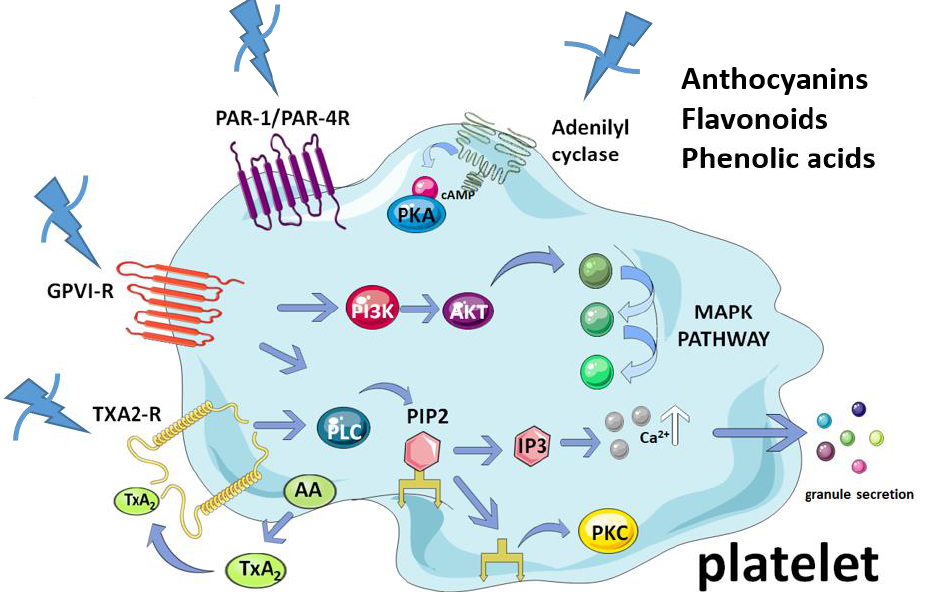
Figure 5. Antiplatelet mechanistic proposal for Maqui. AC, adenylate cyclase; AKT, protein kinase B; cAMP, cyclic adenosine monophosphate; DAG, diacylglycerol; PI 3 , phosphoinositol 3 kinase; PIP2, phosphatidylinositol bisphosphate; GP, glycoprotein; MAP, mitogen-activated protein kinase; P2Y12/P2P1, ADP receptor; TxA 2 R, thromboxane receptor.